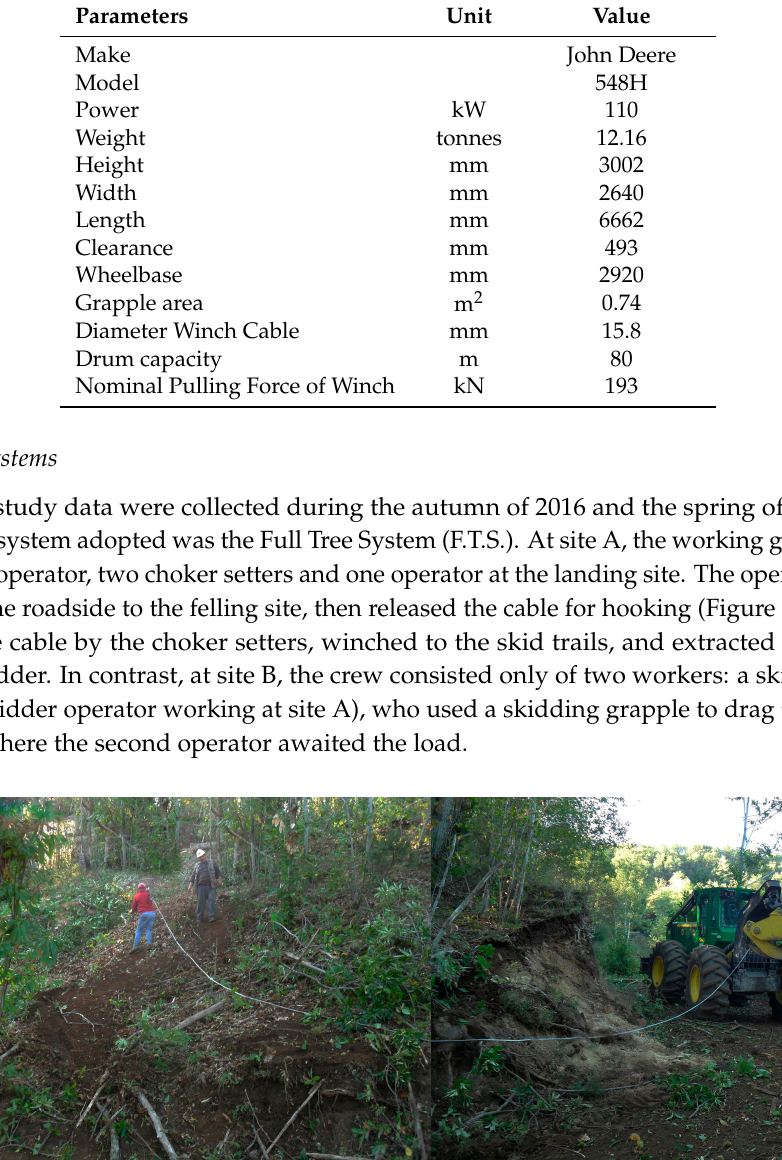
Table 2. Specifications of the skidder.